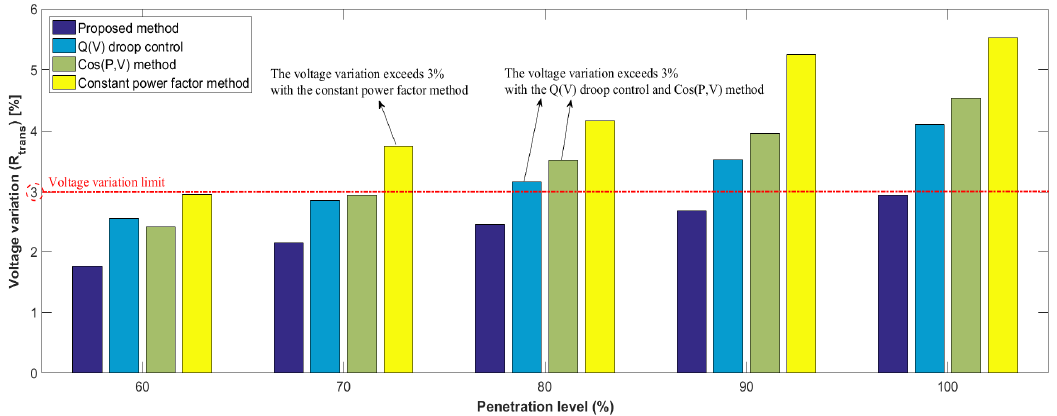
Figure 15. Comparison results for voltage variations with the increasing penetration of DERs.